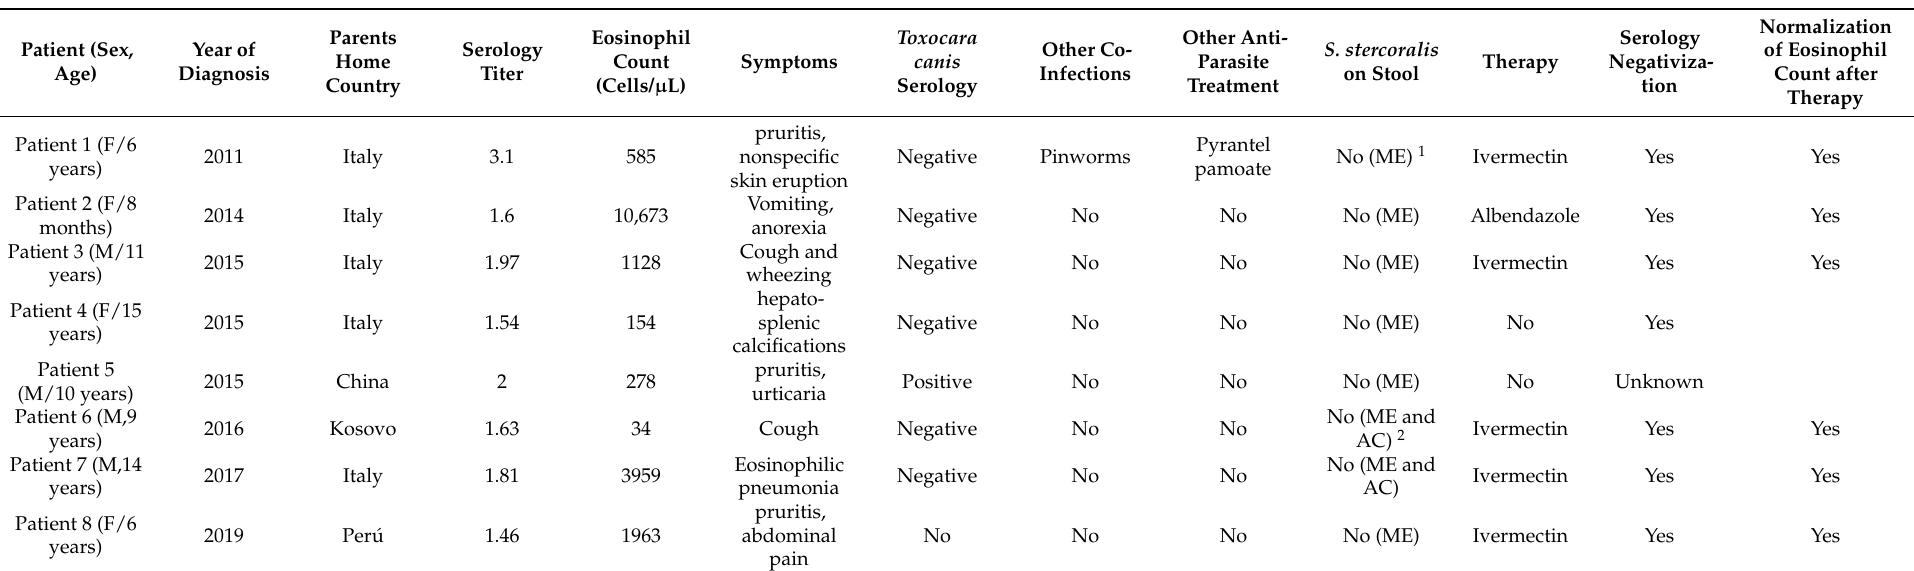
Table 2. Clinical characteristics of Italian-born children without history of travel abroad with positive S. stercoralis